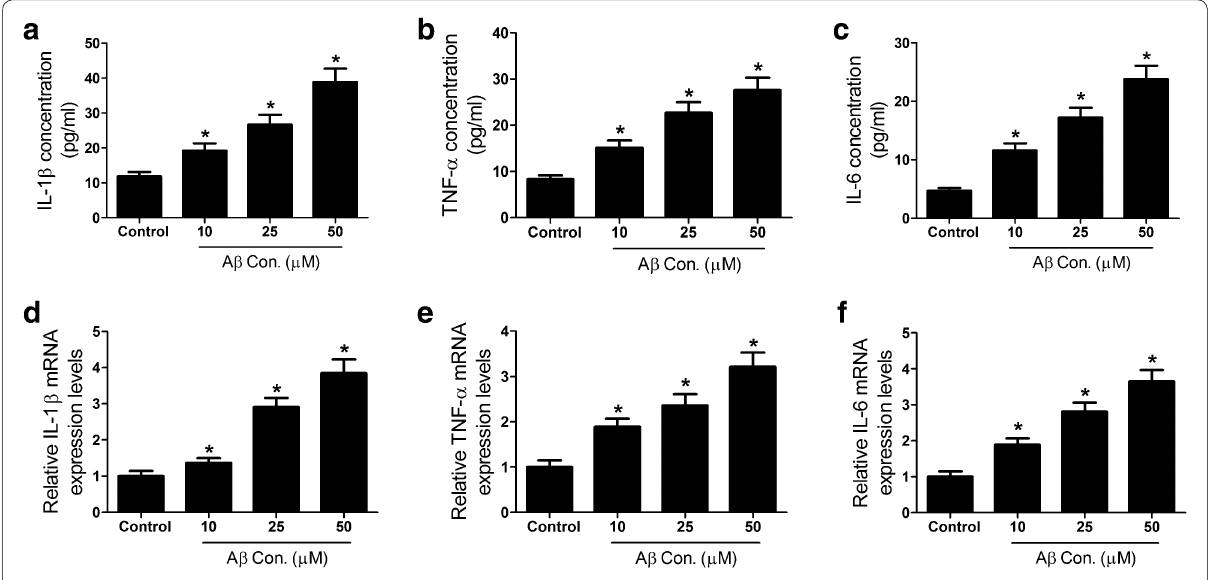
Fig. 2 Aβ treatment increased the levels of inflammatory factors in SH-SY5Y cells. SH-SY5Y cells were treated with different concentrations (0, 10, 25, 50 μM) of Aβ for 48 h. a – c ELISA assay was carried out to measure the concentration of IL-1β, TNF-αand IL-6 in the culture supernatant. d – f qRT-PCR analysis was conducted to detect the mRNA expression of IL-1β, TNF-α and IL-6 in SH-SY5Y cells. * p < 0.05 vs.